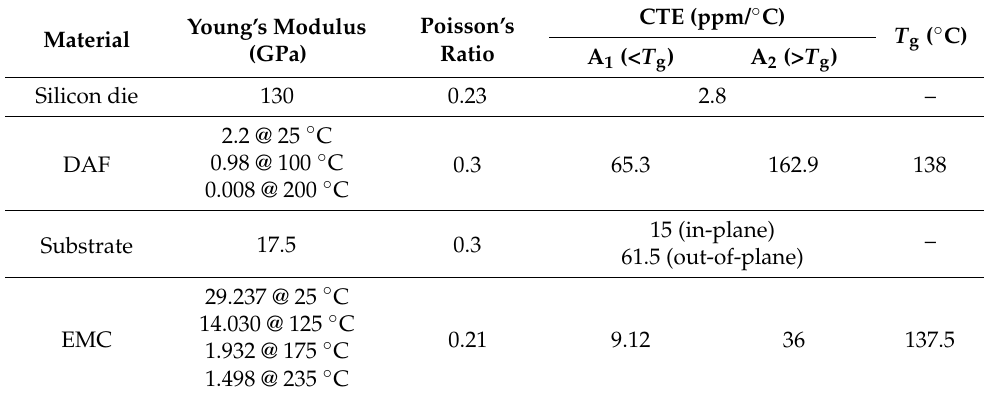
Table 1. Properties of materials used in the TFBGA package.